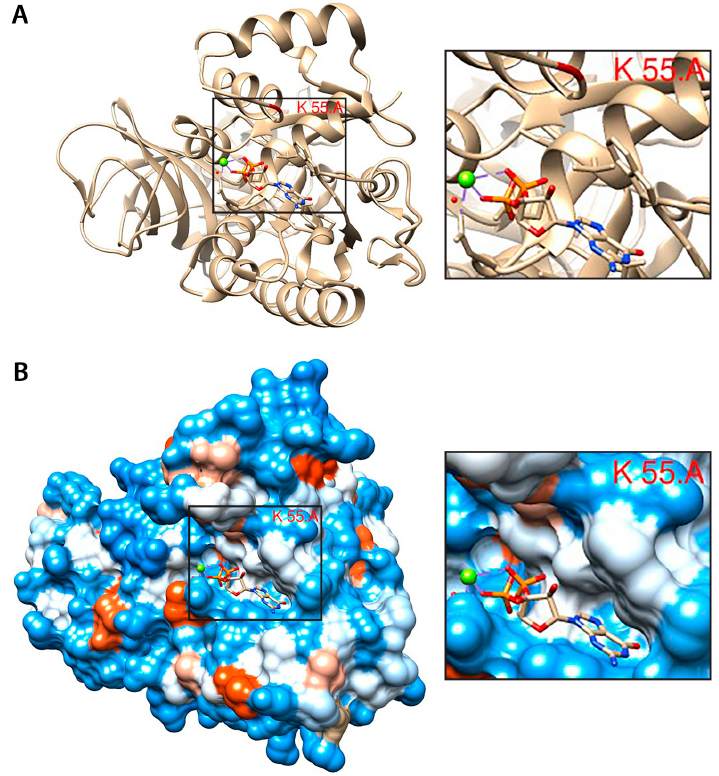
Figure 4. Structure of eEF1A1 and putative EZH2 methylation target site. ( A ) Ribbon structure view of mammalian eEF1A monomer showing close proximity of Lys 55 (highlighted in red) to the GTP/GDP (Guanosine-5'-tri/diphosphate) binding pocket (with a GDP molecule bound in the pocket); ( B ) Hydrophobicity surface view (hydrophobic, red; hydrophilic, blue; neutral, white) of eEF1A1 showing that K55 is in a hydrophilic (blue colour) region close to GTP/GDP binding pocket that is potentially accessible for post-translational modifications and methylation by EZH2. Table 4. Summary of potential non-histone EZH2 enzymatic targets.